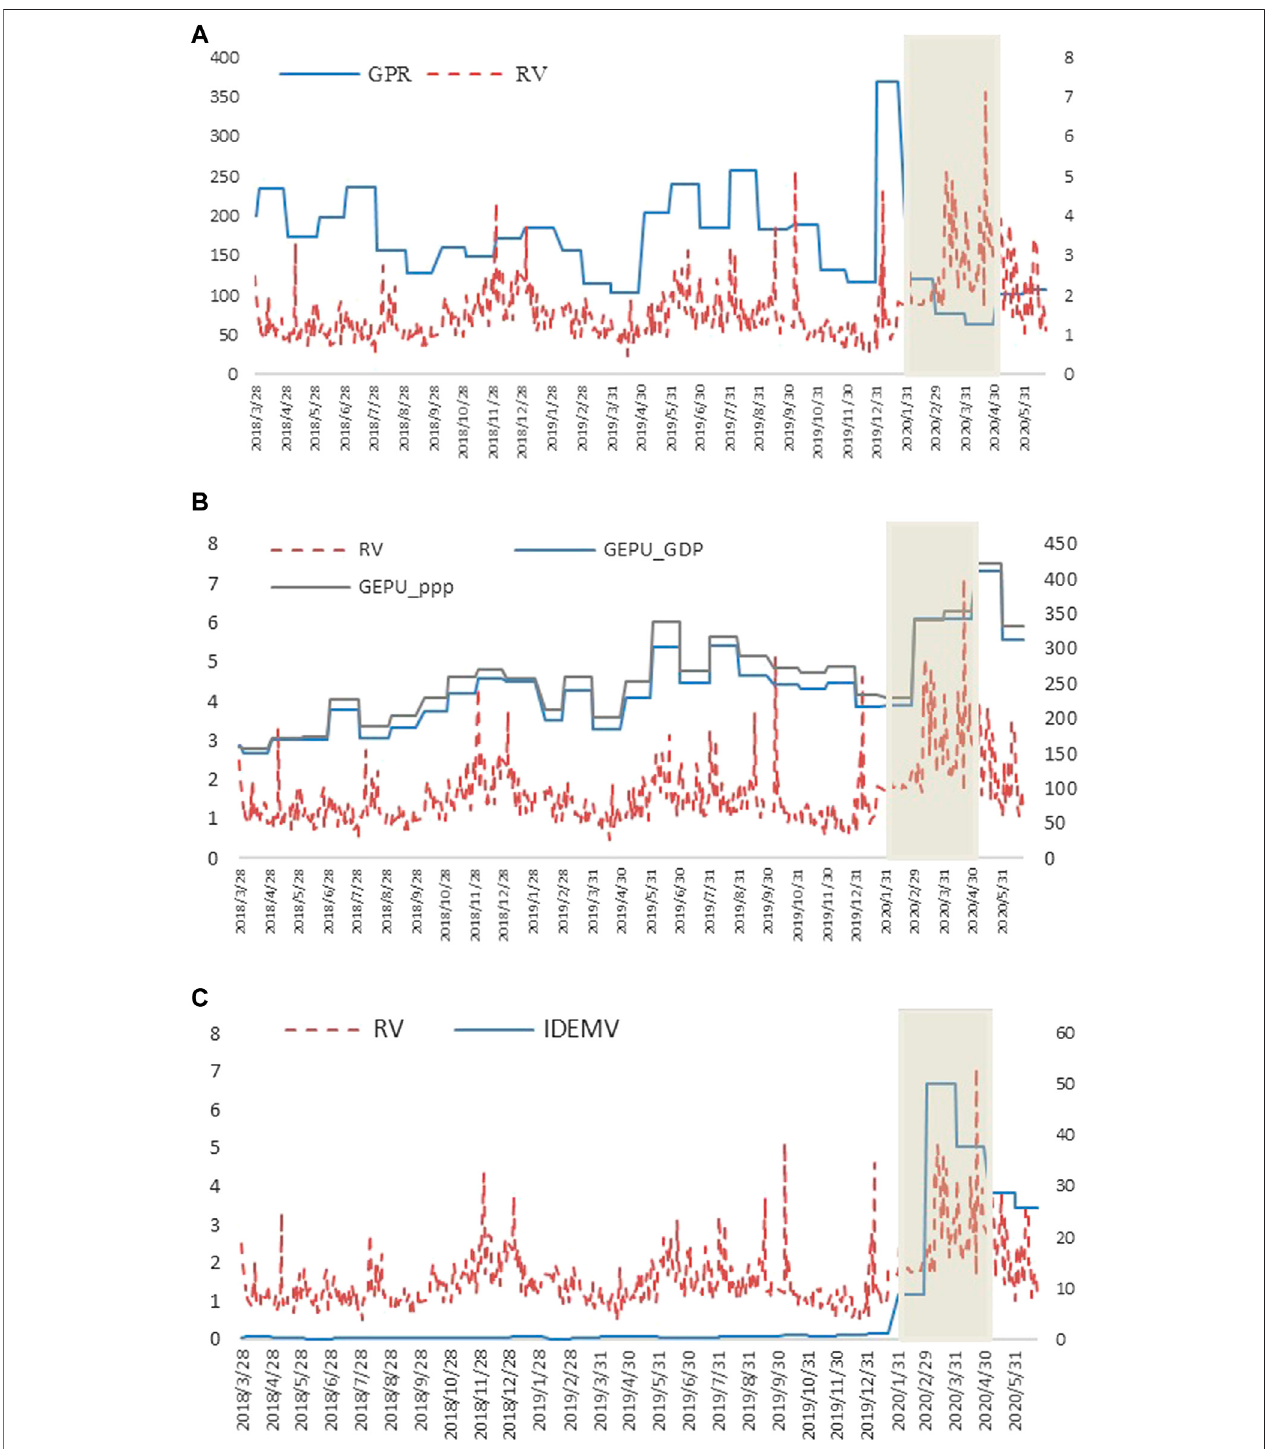
FIGURE2| Thetrends ofINEcrudeoil futuresvolatility, theGPRindex,theGEPUindexand theIDEMVindex. Panel (A) Thetrends ofINE crudeoilfutures volatility andtheGPRindex.Panel (B) ThetrendsofINEcrudeoilfuturesvolatilityandtheGEPUindex.Panel (C) ThetrendsofINEcrudeoilfuturesvolatilityandtheIDEMVindex.